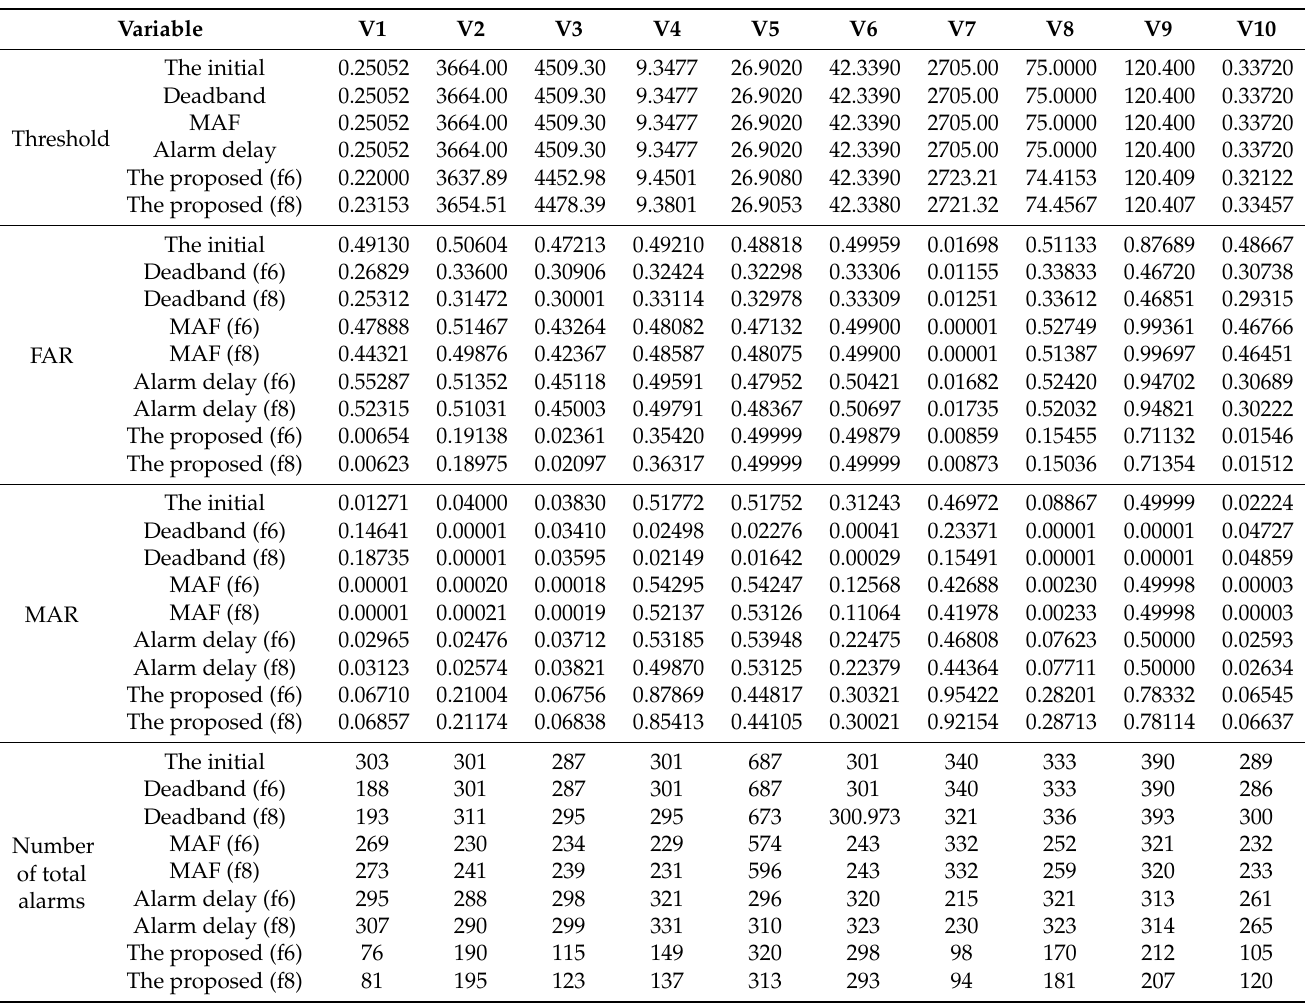
Table 6. Optimized results for ten